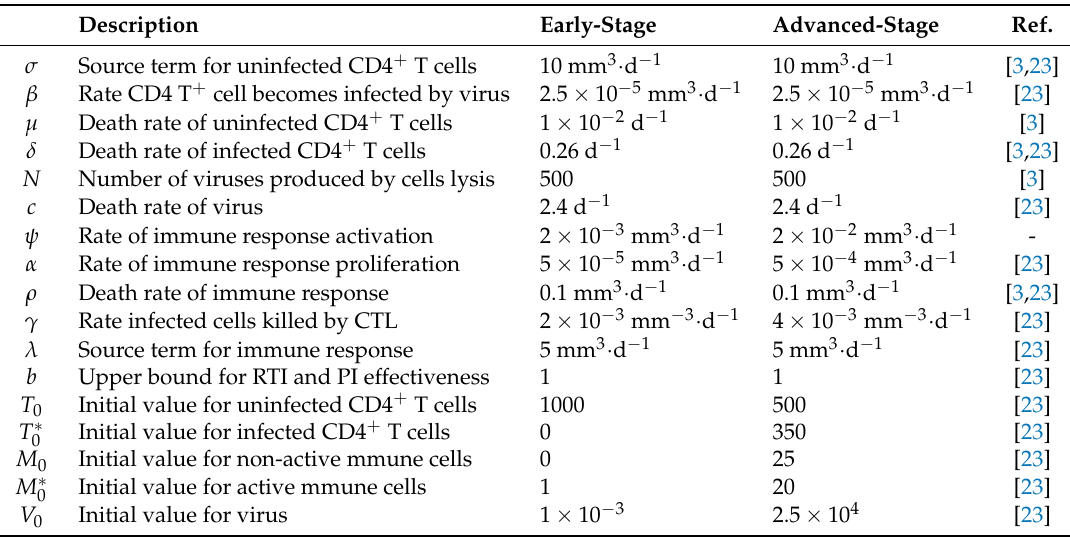
Table 1. Parameter definitions and baseline values (and their corresponding sources) used in numerical